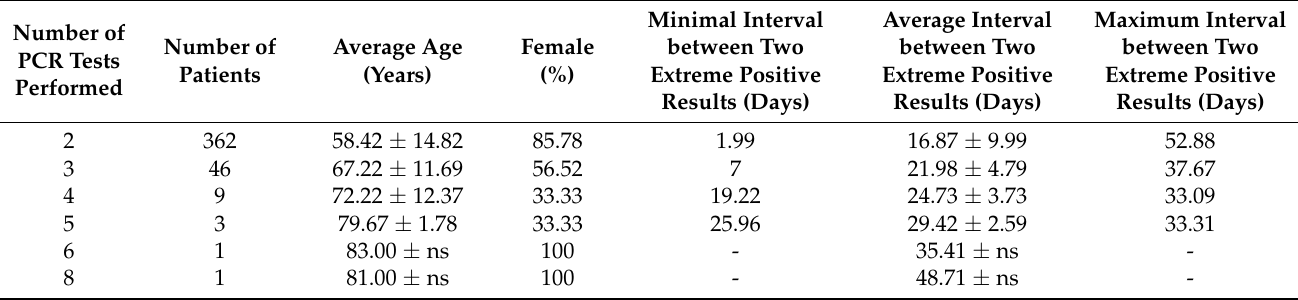
Table 2. Patients according to long-lasting symptoms.